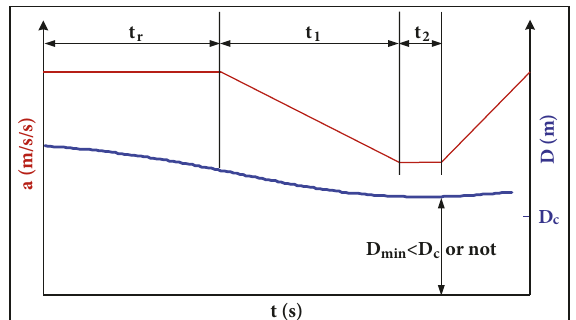
Figure 6: Three simplified phases in the rear-end collision avoid- ance